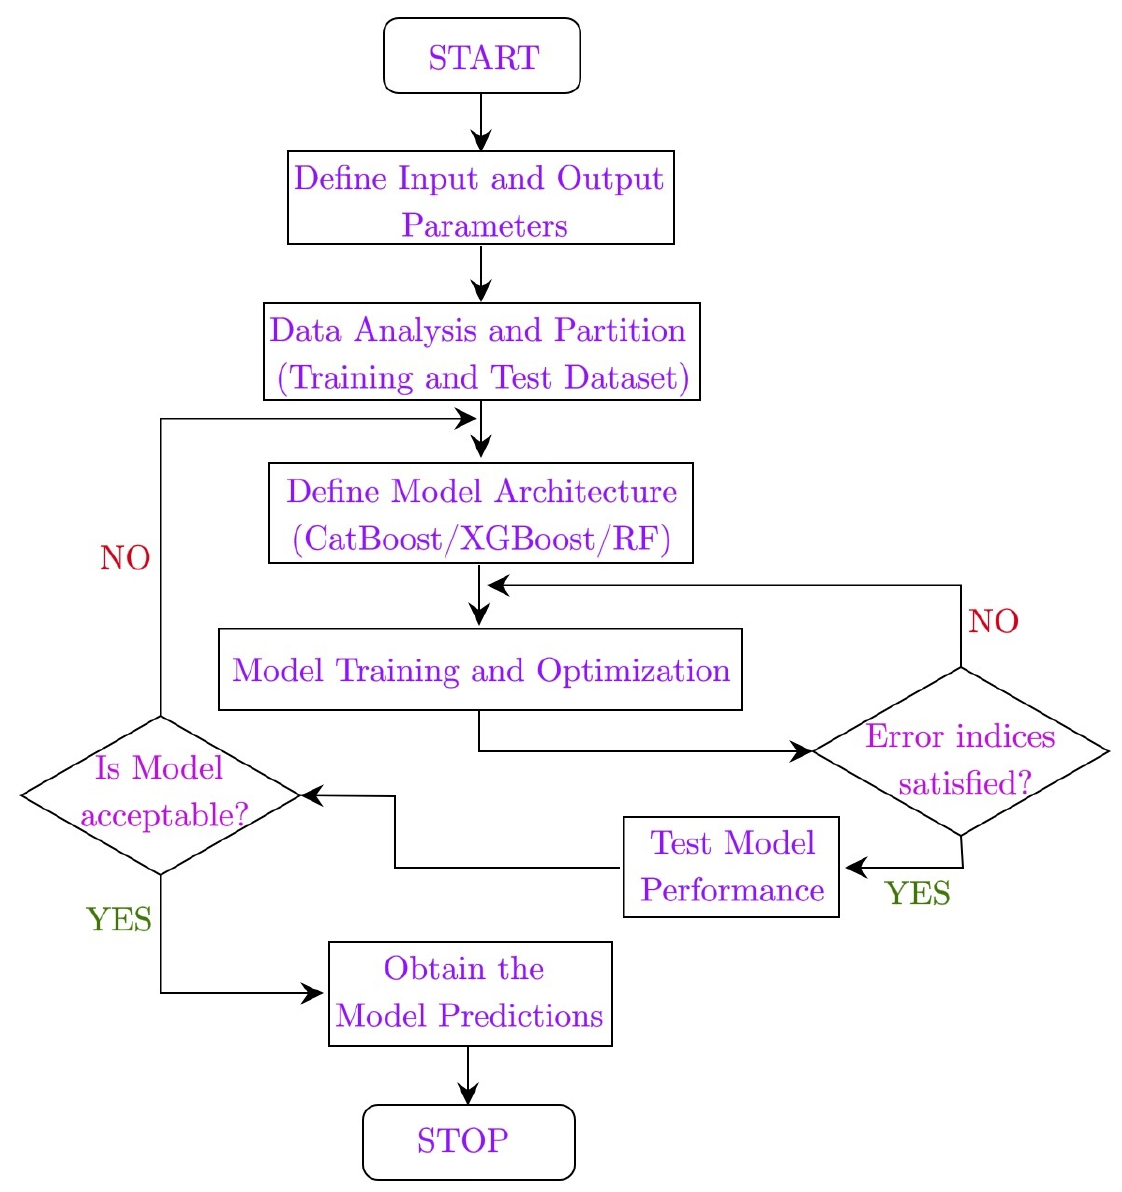
Figure 1. The modeling procedure of the metaheuristic regression methods implemented in this study.